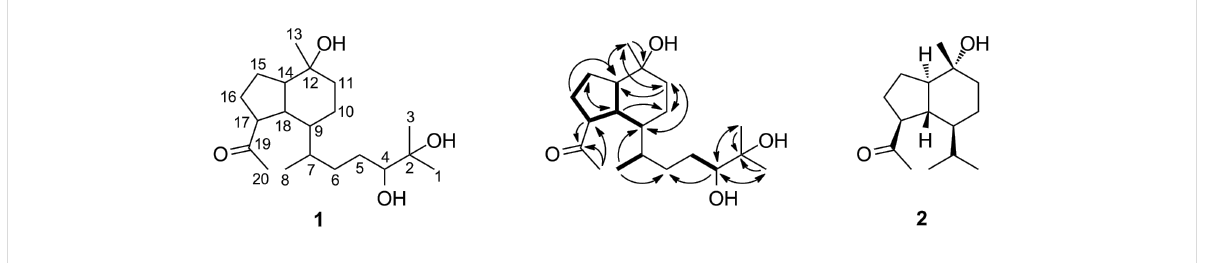
Figure 3: Structures of herpetopanone ( 1 ) and oplopanone ( 2 ), as well as selected COSY (bold lines) and HMBC (arrows) interactions in 1 .